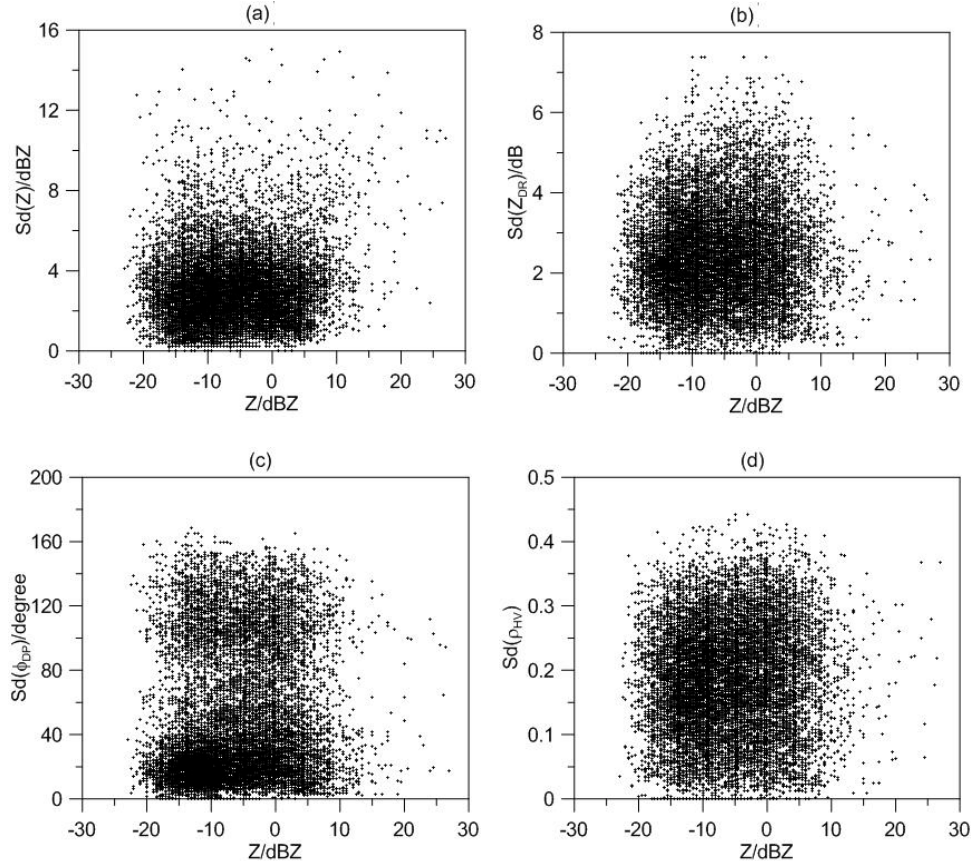
Figure 6. Scatterplots of ( a ) Sd(Z), ( b ) Sd(Z DR ), ( c ) Sd( Φ DP ), and ( d ) Sd( ρ HV ) versus Z for CAT from Changping radar, 1.5° PPI, at 08:00 UTC 2 July 2019.